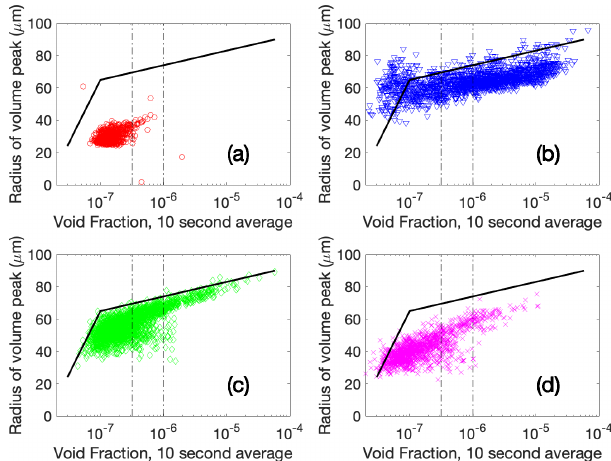
Figure 7. Scatter plots showing the 10s averaged void fraction against the peak radius in the volume distribution at 2m depth. Panel (a) shows station 3, (b) station 4, (c) station 6 and (d) is sta- tion 7. The black lines are the same on all plots and follow the en- velope of the data in (c) . The lines are at 10 ( − 6 . 5 ) and 10 ( − 6 ) to allow comparison between plots. We note that the triangles in the top left of plot (b) , significantly above the black lines, are all in the eye of the storm: a period of very low winds following very high winds. They appear to be bubbles that are stable for several hours after wave breaking events have